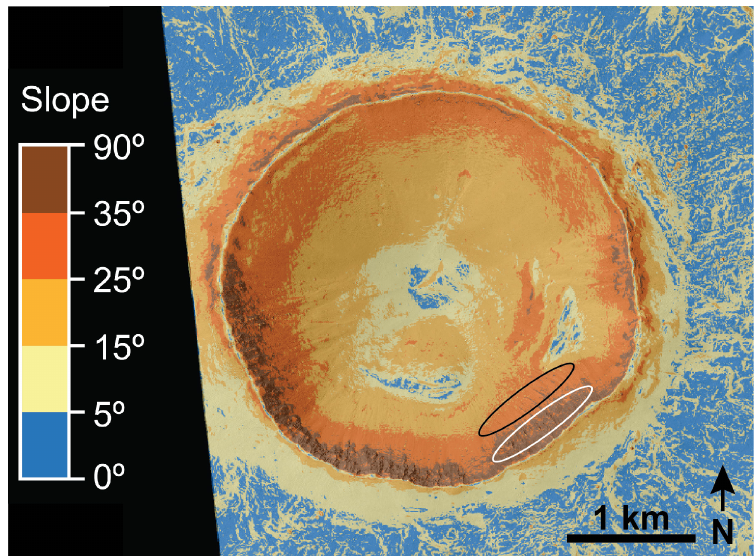
Figure 12. Example slope map derived from a DTM of Tivat crater (45.9 ◦ S, 9.54 ◦